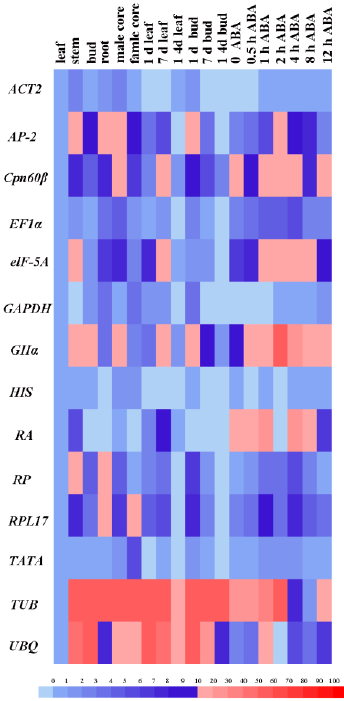
Figure 2. Expression stability of the tested 14 reference genes in all 19 samples. The line shown in the box indicates the median Ct value. The upper edge of each box indicates the 25th percentile and lower indicates the 75th percentile.